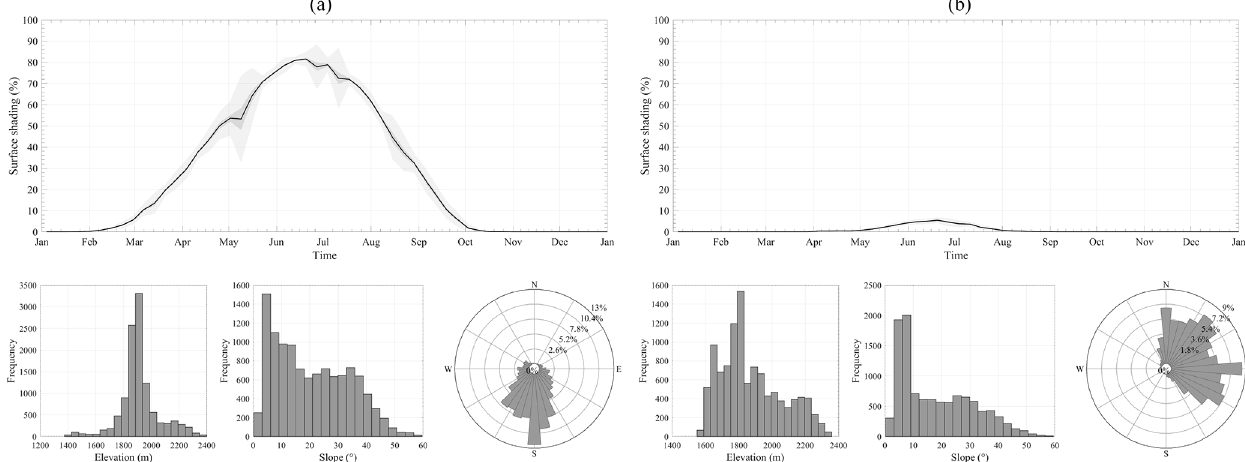
Figure 3. Surface shading and hypsometry of (a) Abel Glacier and (b) Angel Glacier in the GoEA. Shading is displayed over 1 year, calculated as a weekly average between 2000 and 2018, used to indicate the nature of the surrounding topography. Topographic measures of (a) elevation, (b) slope and (c) aspect are calculated at 15m resolution from the NZSoSDEM. Table 2. Physical characteristics of the 12 outlet glaciers in the GoEA identified for MODIS-albedo retrieval, calculated from the 15m resolution NZSoSDEM. Cluster membership is defined by K -means cluster analysis of aspect, slope and topographic shading. An estimate of the number of 250m raster pixels in each individual glacier mask can be found by dividing the total area by 0.0625km 2 . Glacier Area Aspect Elevation Slope Topographic Cluster Name (km 2 ) (m) ( ◦ ) Shading (%) Abel 2.57 S